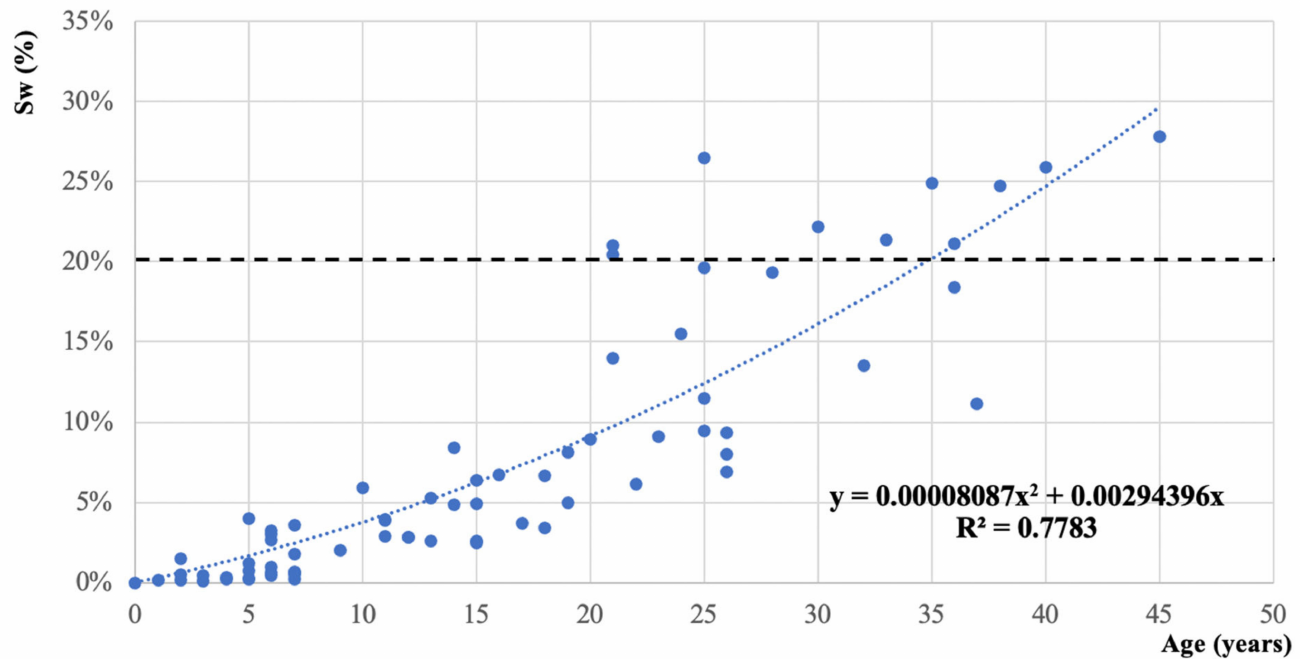
Figure 4. Physical degradation curve obtained for the 72 timber claddings